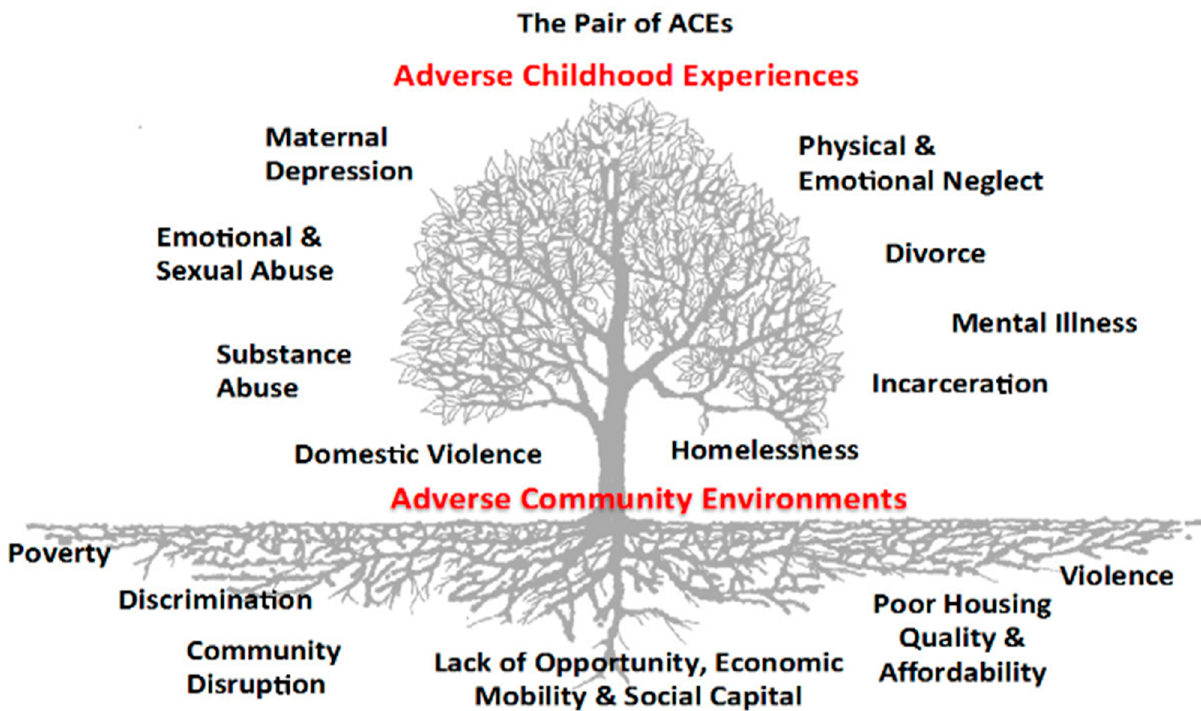
Figure 2. The Pair of ‘ACEs’. Source: NHS Highland (2018, p. 15).